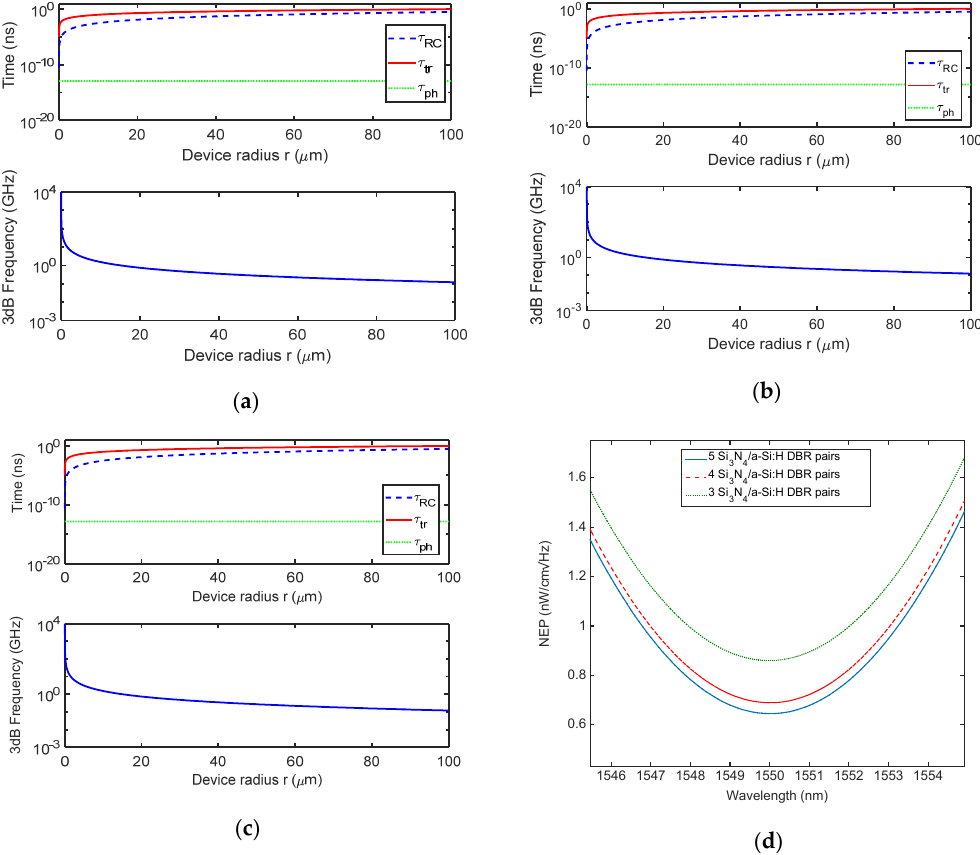
Figure 9. Carriers transit time τ tr , charge/discharge time τ RC , cavity photon lifetime τ ph and 3 dB roll-off frequency versus graphene disk radius r for the TCC Fabry-Pérot graphene/Si Schottky PD provided of a DBR output mirror constituted by ( a ) 3, ( b ) 4 and ( c ) 5 pairs of Si 3 N 4 /a-Si:H and ( d ) spectral noise equivalent power (NEP).